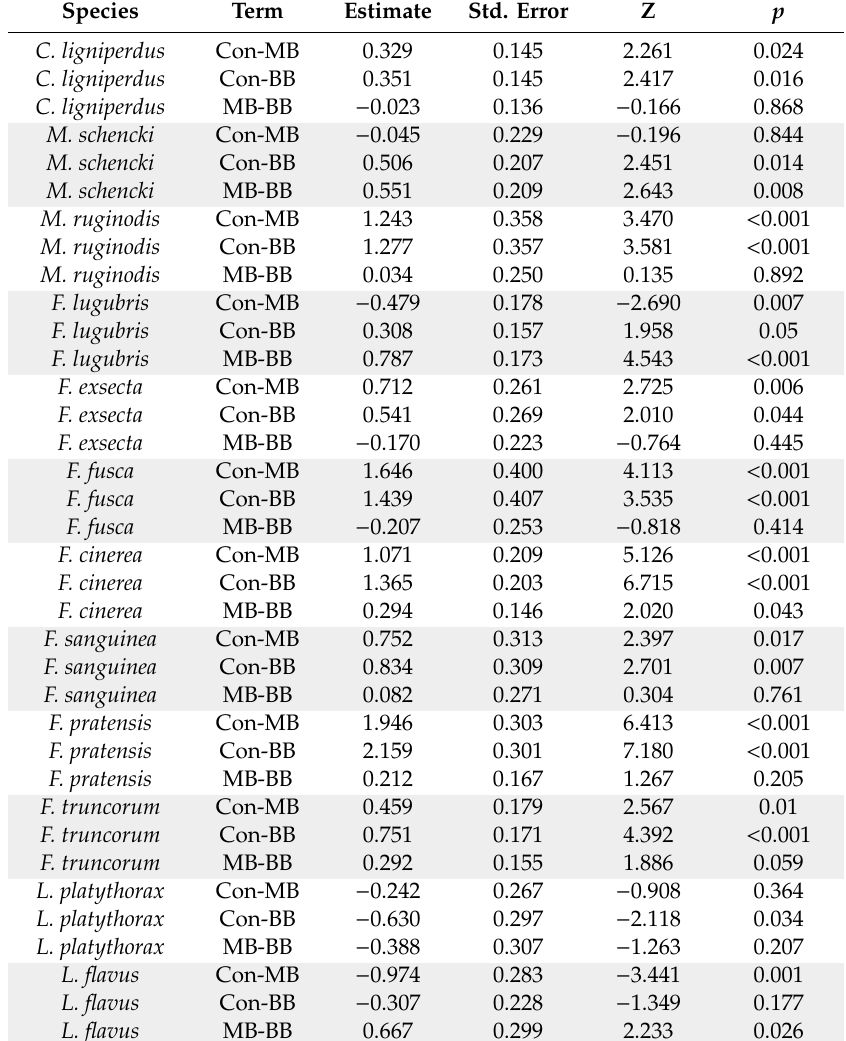
Table 2. Autogrooming. Comparisons of autogrooming behaviors between control ants (Con), ants exposed to B. bassiana (BB), and ants exposed to M. brunneum